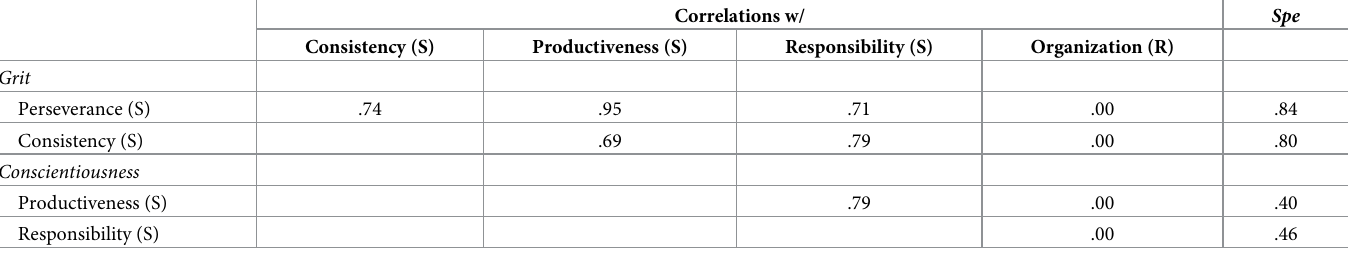
Table 3. Latent correlations and specificity coefficients (Spe) for the facets of Grit and Conscientiousness in the bifactor-(S–1) model with organization as the refer- ence facet (Model